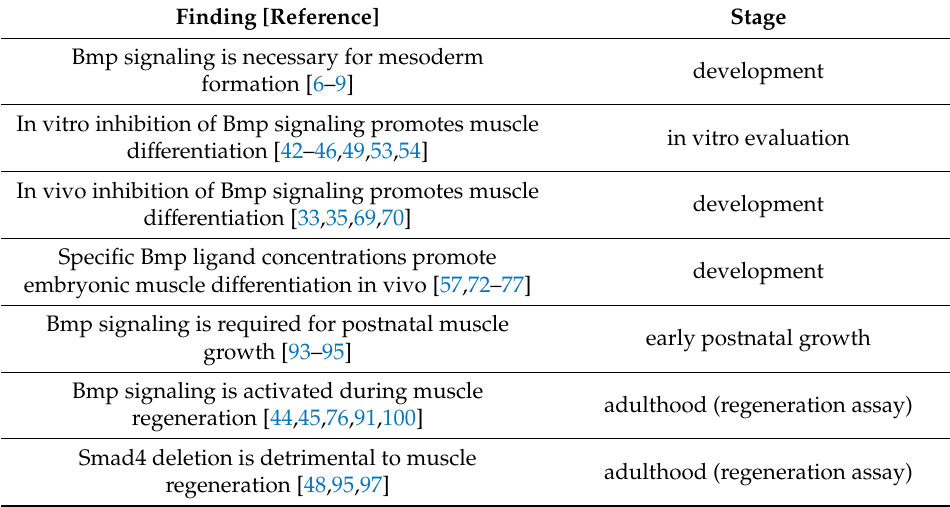
Table A1. Major Findings on BMP E ff ects on